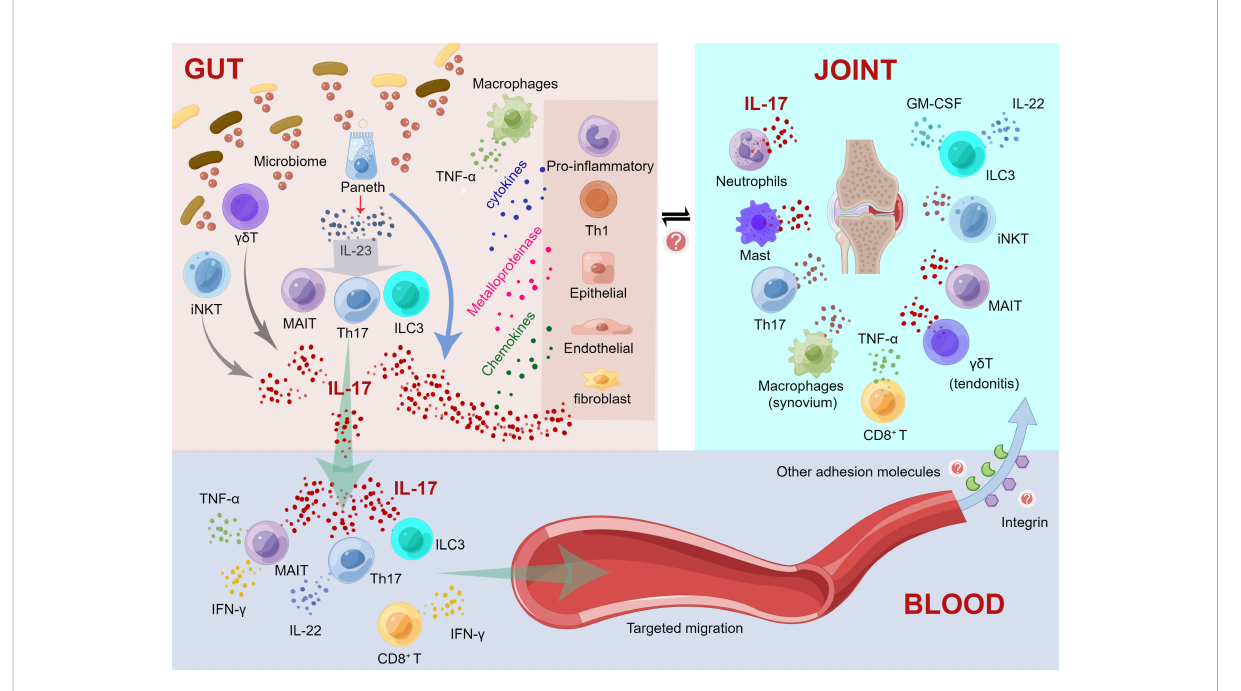
FIGURE 1 Mechanistic model regarding the intestinal in fl ammation driving immune damage in peripheral joints. (1) Immunological changes in the gut . a) Activated Paneth cells produce IL-23 and IL-17 after recognizing the altered microbiome; IL-23 causes the differentiation of Th17, ILC3 and MAIT cells; and these activated cells foster the production of elevated levels of IL-17. IL-17 acts as an in fl ammatory mediator to stimulate the production of cytokines by other proin fl ammatory cells and Th1 cells and promotes the production of metalloproteinases and chemokines by macrophages, epithelial cells, endothelial cells, and fi broblasts, thereby triggering and maintaining in fl ammation. b) gd T and iNKT cells can recognize microbial antigens and release IL-17. c) Simultaneously, macrophage recruitment promoted the secretion of TNF- a . (2) Cytokine cascades initiated in blood vessels. a) IL-17, Th17 cells, ILC3 and MAIT cells can migrate through the intestinal mucosal barrier to the blood, and these cells may transfer in fl ammation to the joints. b) Th17, gd T, ILC3 cells and MAIT cells are induced to produce IL-17 in the bloodstream; Th17 cells also produce IL-22. c) MAIT cells also contribute to the production of TNF- a and IFN- g . d) CD8 + T cells produce IFN- g . (3) Targeting migration and immune response of extraintestinal joint sites . a) Activated cytokines migrate to in fl ammatory sites, such as the axial/peripheral joints, for immune interference. b) Some adhesion molecules, such as integrins, may contribute to the target migration of these immune cells circulating in the blood to peripheral joints. c) In peripheral joints, neutrophils, mast cells, Th17 cells, CD8 + T cells, MAIT cells and iNKT cells induce IL-17 production. ILC3 cells produce IL-22 and GM-CSF, whereas IL-17 is only produced in axial joints. d) gd T cells promote tendonitis through elevated IL-17. e) Macrophages induce TNF- a production in the synovium. This fi gure was drawn by